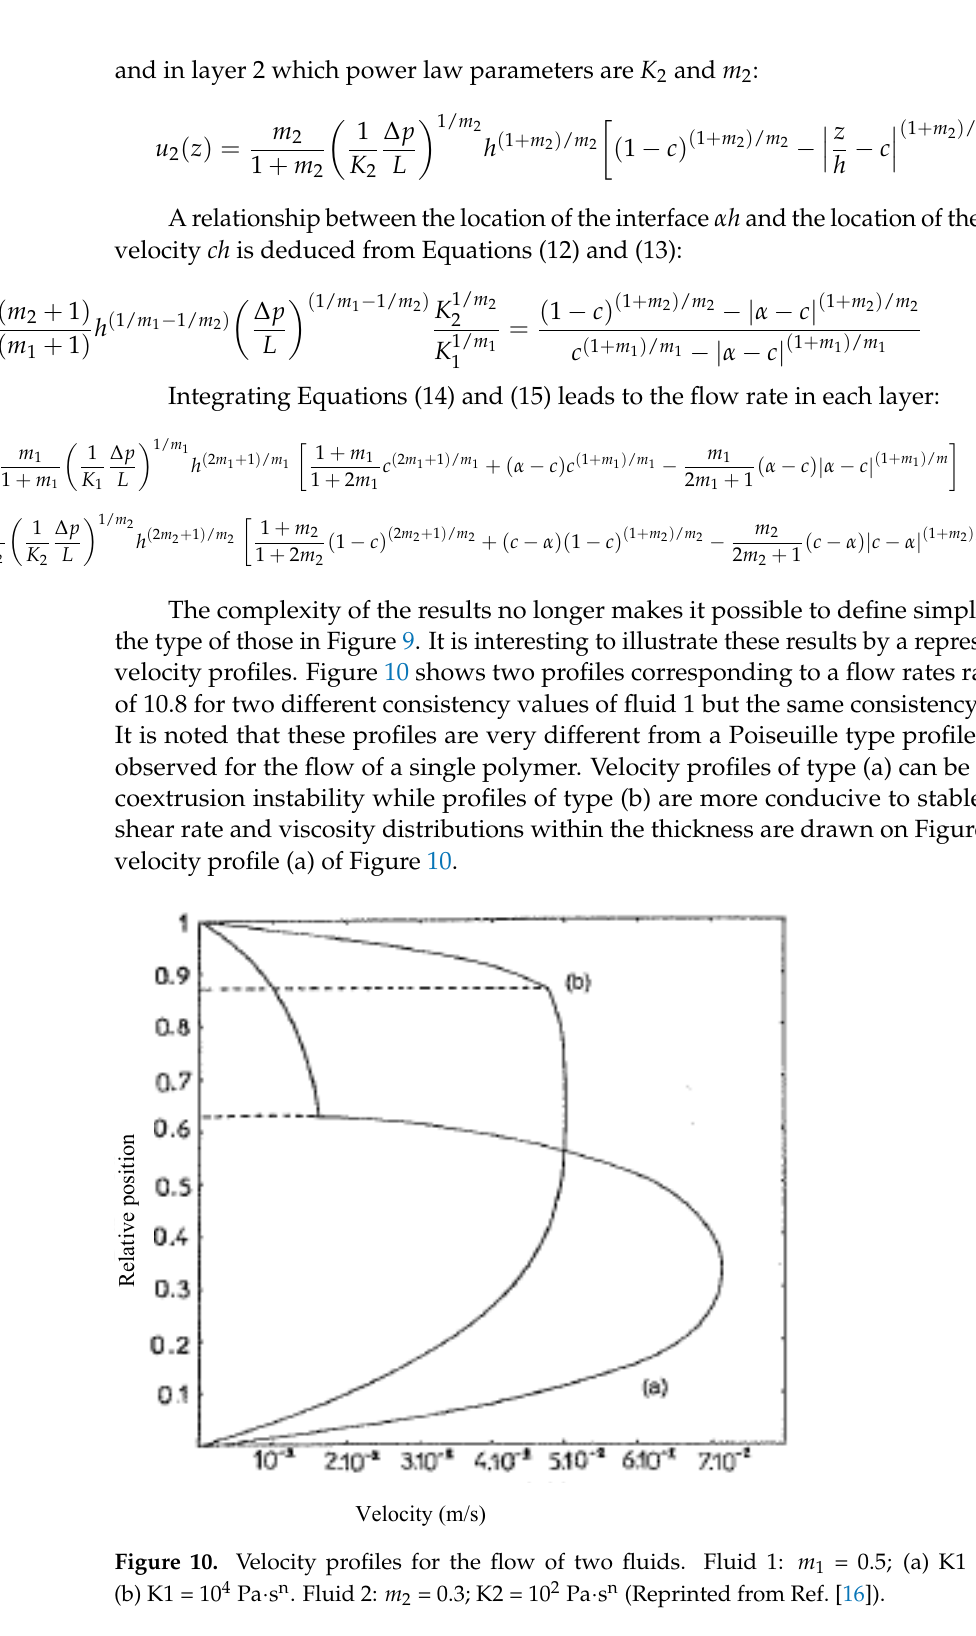
Figure 11. Shear rate ( ■ , □ ) and viscosity ( ● , ○ ) through the gap for the velocity profile (a) of Figure 10 (Reprinted from Ref. [2]). The continuity of the shear stress at the interface between the layers results in dis- continuities, which can be very large, in both shear rate and viscosity. This points out that the viscosity ratio of the two polymers, which is a key parameter in Newtonian cases, but which is also very widely used in practice in most coextrusion problems, loses all its mean- ing as soon as it is applied to non-Newtonian polymer fluids. The infinite viscosity calcu- lated at the maximum velocity of Figure 10, therefore for a zero-shear rate, is an artefact of the power law viscosity model (Equation (10)). To account for the existence of a New- tonian plateau at low shear rate, it is necessary to use more sophisticated constitutive equations, as the generalized Carreau law [17]: